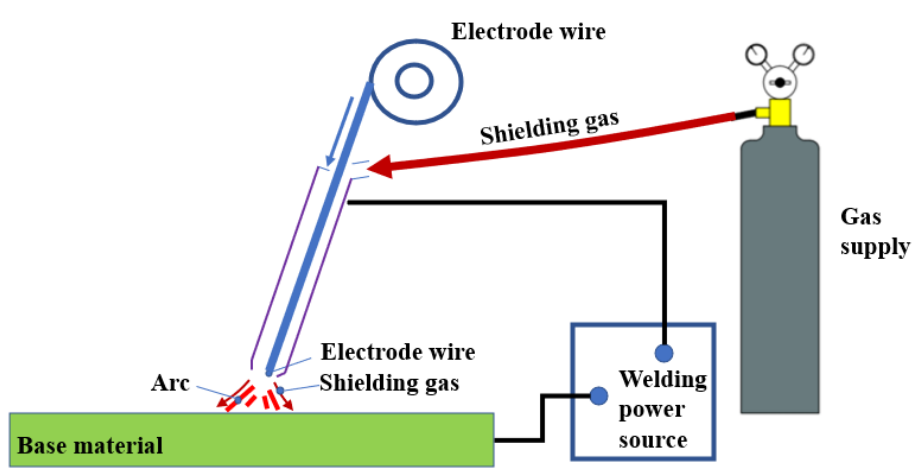
Figure 4. Mechanism of MIG welding process.